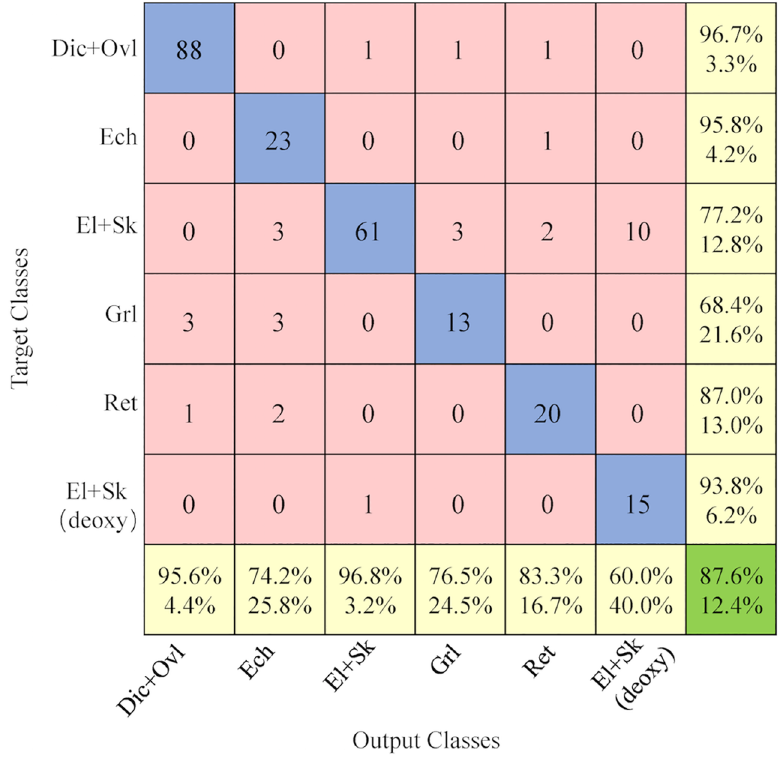
Fig 21. Confusion matrix for the combined oxygenated and deoxygenated categories described in Table